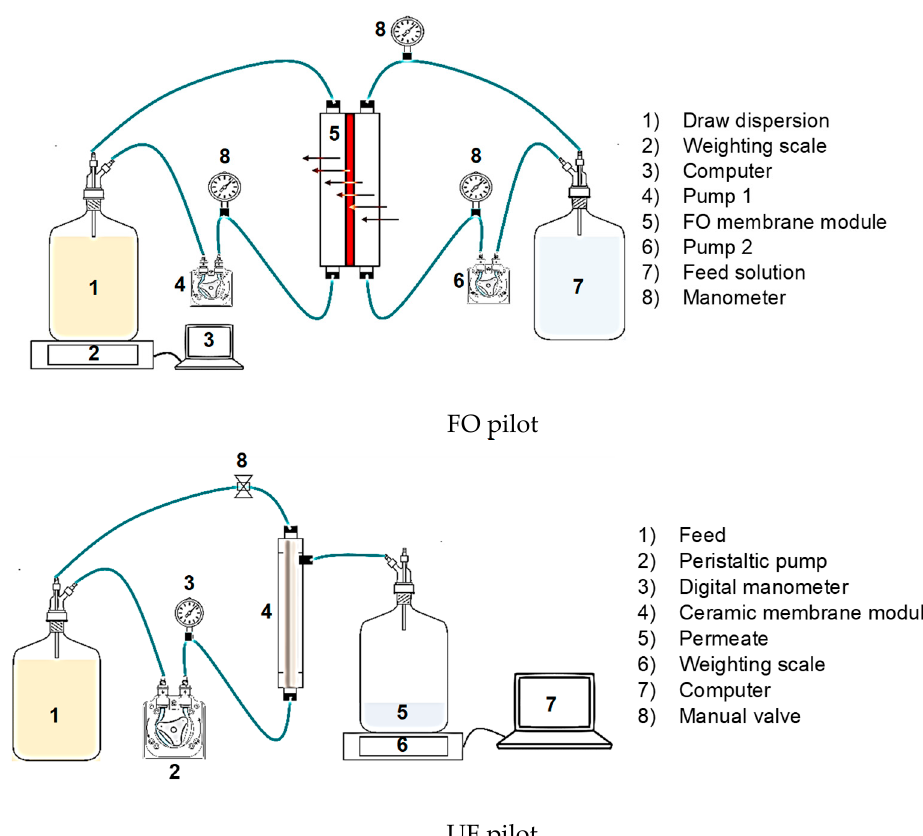
Figure 5. Osmolarity measurements with the ionosilica hydrogel dispersions at various concentrations. In a second time, pilot tests were run to evaluate the osmotic performance of ionosilica hydrogel dispersions as draw solutes using a 0.1 g·L − 1 NaCl aq. feed. The semi-industrial FO pilot used in this study is schematized in Figure 6, top.